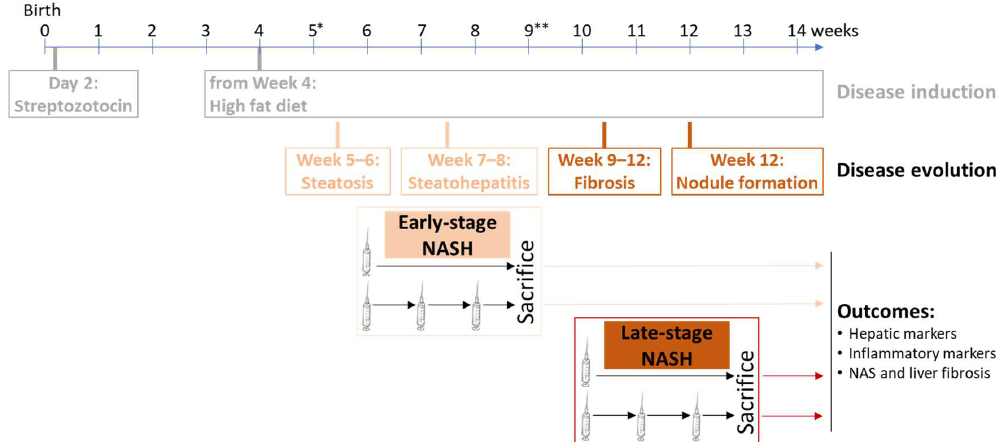
Figure 4. STAM mouse model and HALPC transplantation protocol applied. NASH was induced in C57BL/6 male mice by a single subcutaneous injection of 200 µg streptozotocin 2 days after birth and by solid high-fat diet ad libitum after 4 weeks of age. HALPCs (either single or triple injections of 12.5 × 10 6 cells/kg body weight) or the vehicle (saline solution 0.9%) were administered via the tail vein at week 6 (1 dose) or weeks 6, 7, and 8 (3 doses) for early stage NASH, or at week 10 (1 dose) or weeks 10, 11, and 12 (3 doses) for late-stage NASH. Mice viability, clinical signs, and behavior were monitored daily. The mice were sacrificed by exsanguination through direct cardiac puncture under isoflurane anesthesia at weeks 9 and 13 for early and late-stage NASH, respectively. Immunosuppression (with cyclosporine 5 mg/kg every other day) started at *Week 5 for early-stage NASH or at **Week 9 for late-stage NASH.